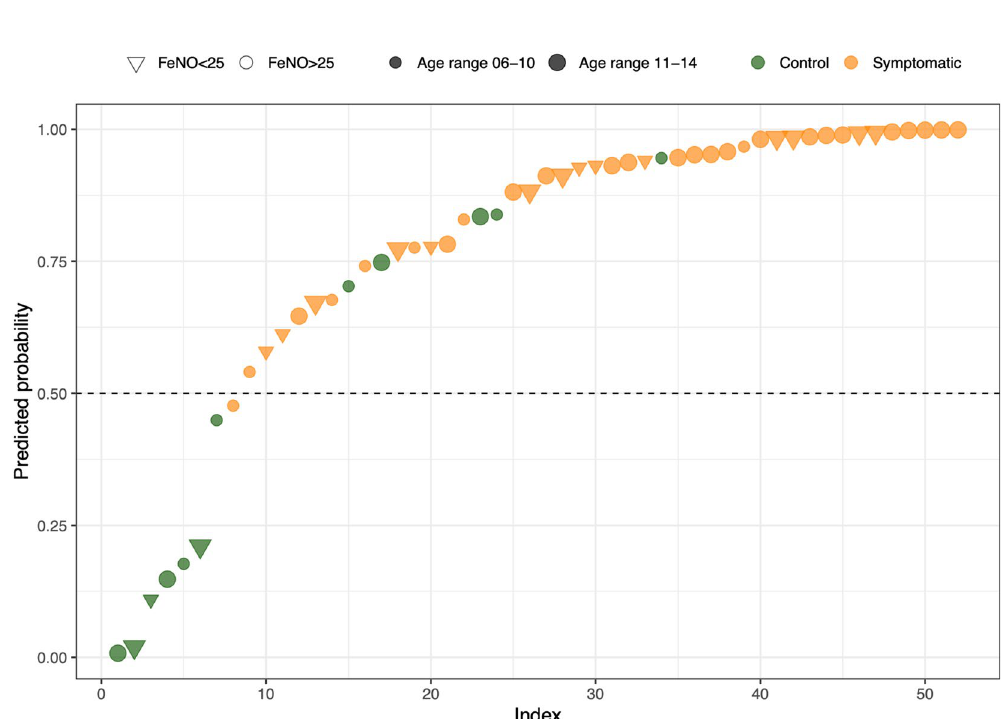
Figure 5. Ranking of AR symptomatic (orange) and control (green) patients, based on likelihood of showing symptoms, differentiated by FeNO measurement levels (triangle FeNO < 25, circle FeNO ≥ 25) and age range (smaller shape 6–10, bigger shape